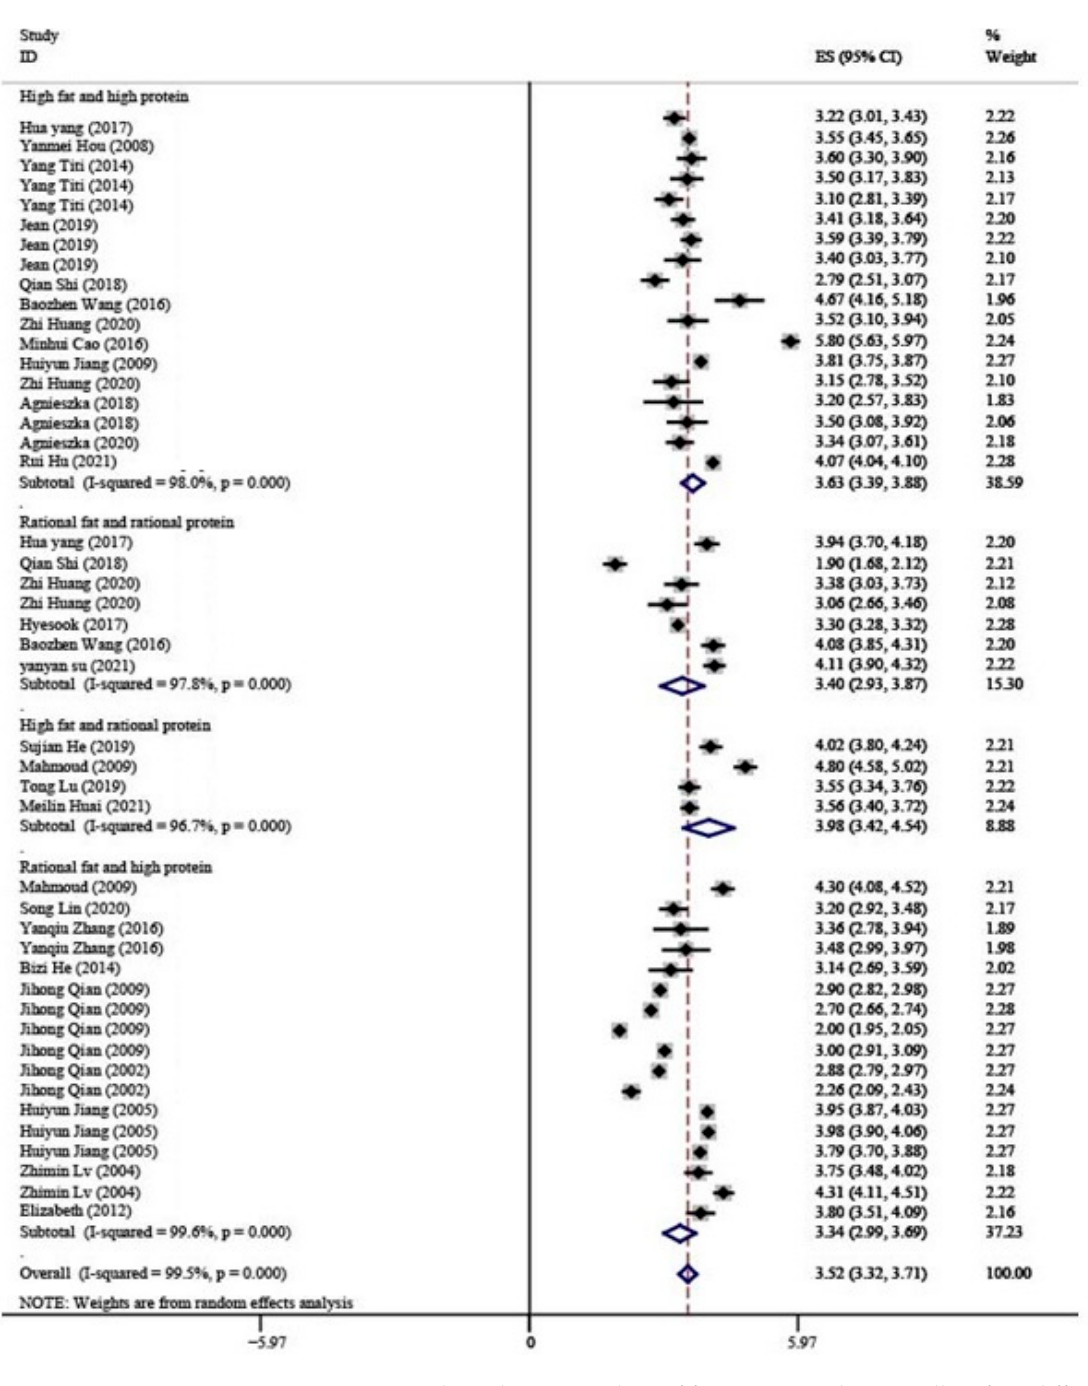
Figure 3. Forest map show the mean values of fat contents in breast milk at four different dietary patterns [26–61].